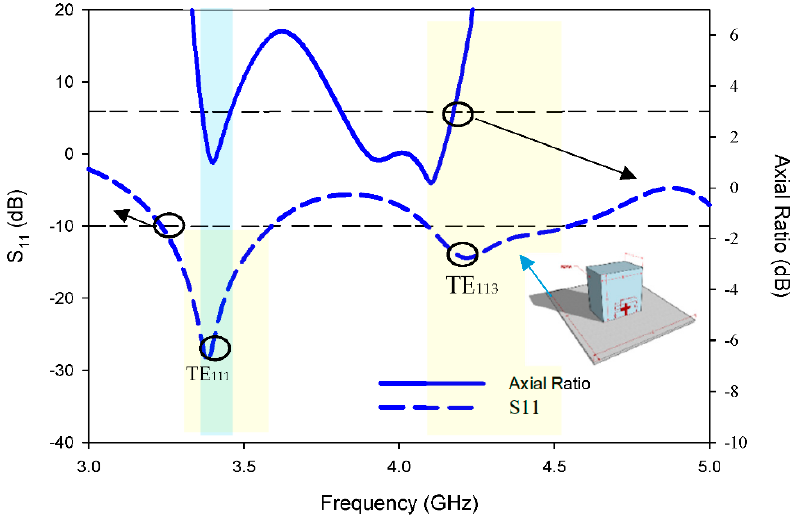
Figure 6. Simulated S-parameter and Axial ratio of the cross-shaped RDRA.